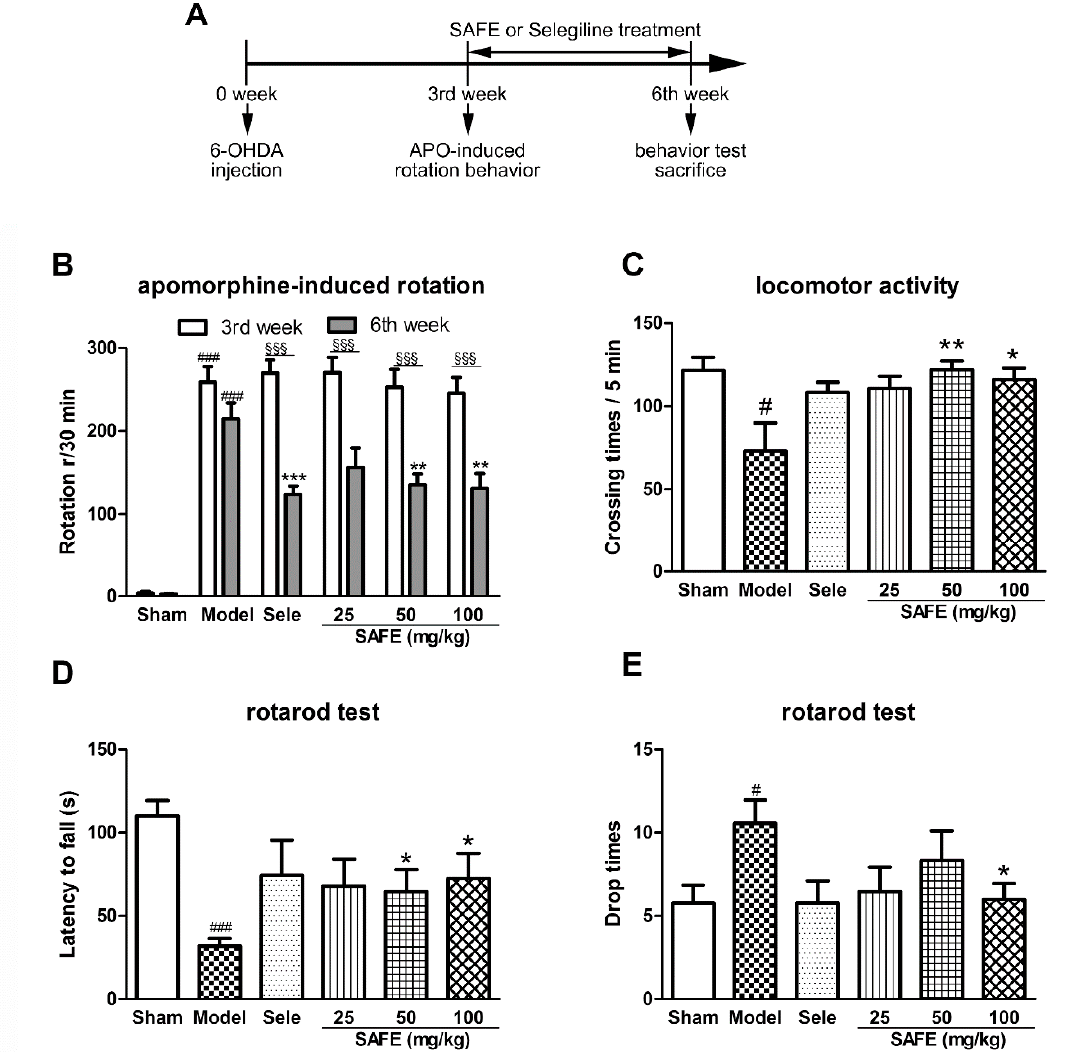
Figure 1. ( A ) Flow chart of the experimental setup. Effect of safflower flavonoid extract (SAFE) on motor function of 6-OHDA-induced Parkinson’s disease (PD) mice. ( B ) Apomorphine-induced rotational behavior of mice at the 3rd week and 6th week; ( C ) Locomotor activity was assessed using a mouse autonomous activity instrument at the 6th week; ( D ) Latency to fall represents time from start to first fall from rod on rotarod test at the 6th week; ( E ) Drop times of mice represent the number falls from the rod within 180 s on the rotarod test at the 6 th week. n = 9. Sele, selegiline 15 mg/kg control group. # p < 0.05, ### p < 0.001 vs. sham group. * p < 0.05, ** p < 0.01, *** p < 0.001 vs. model group and